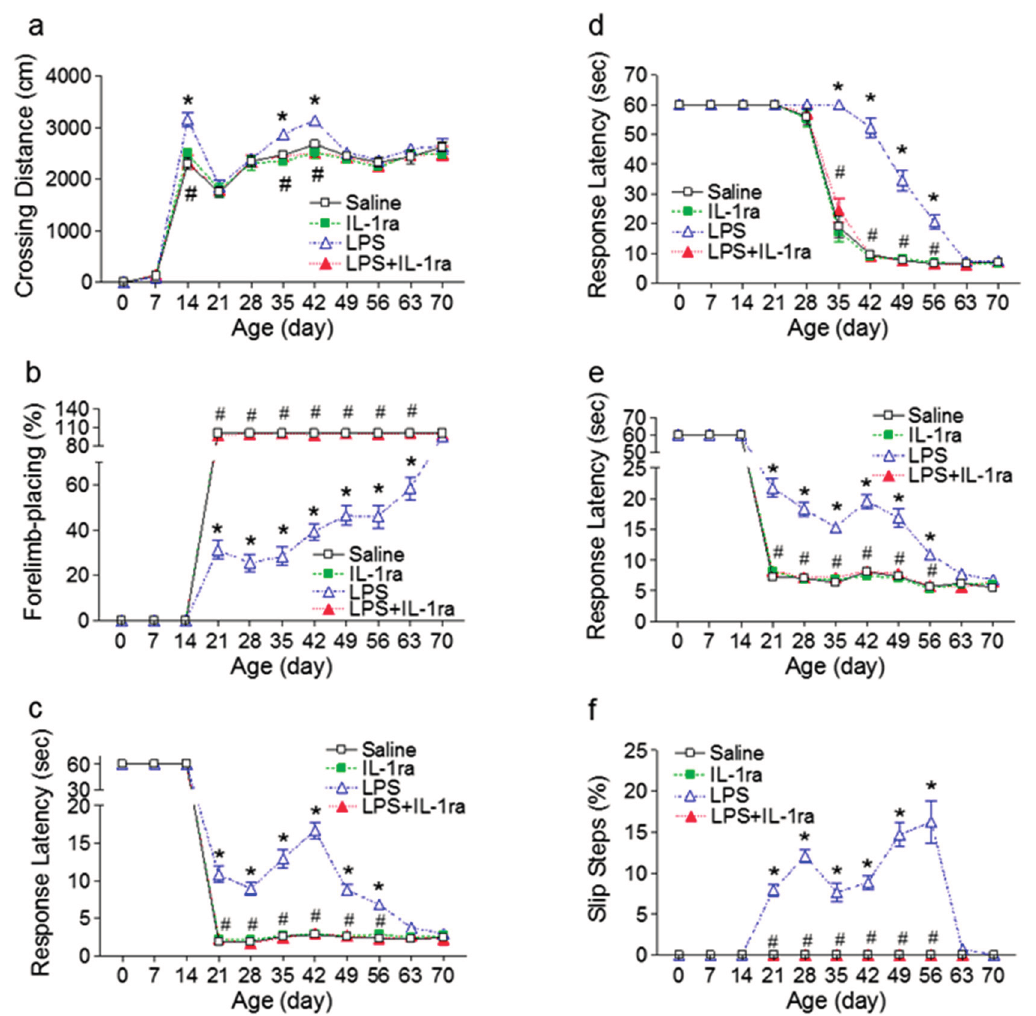
Figure 1. IL-1ra attenuated LPS-induced deficits in motor behaviors in rats from P7 to P70 rats. ( a ) Locomotor activity, as determined in the open field test; ( b ) The vibrissa-elicited forelimb-placing test; ( c ) The movement initiation test; ( d ) The pole test; and ( e , f ) The tapered/ledged beam walking test as determined by slip step ratio ( e ) and performance latency ( f ). The results are expressed as the mean ± SEM of 12 animals in each group, and analyzed by two-way repeated measures ANOVA for data from tests conducted continuously at different postnatal days. * p < 0.05 represents significant difference for the LPS group as compared with the saline group on the same postnatal day. # p < 0.05 represents significant difference for the LPS+IL-1ra group as compared with the LPS group on the same postnatal